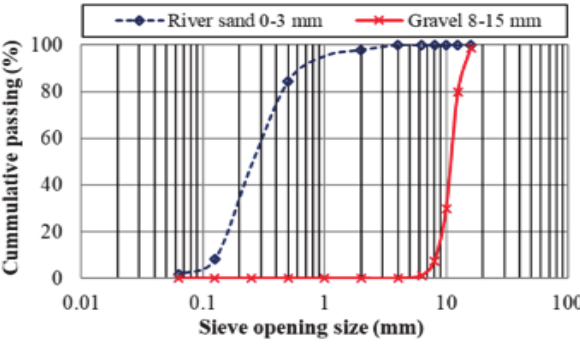
Figure 1: Grading of gravel and sand.